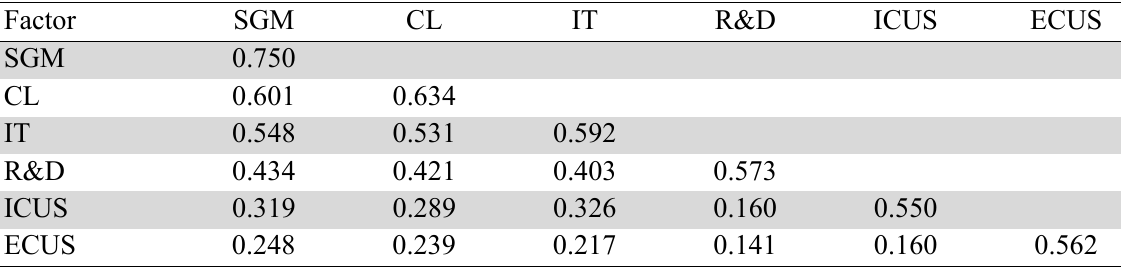
Discriminant validity analysis of MKM